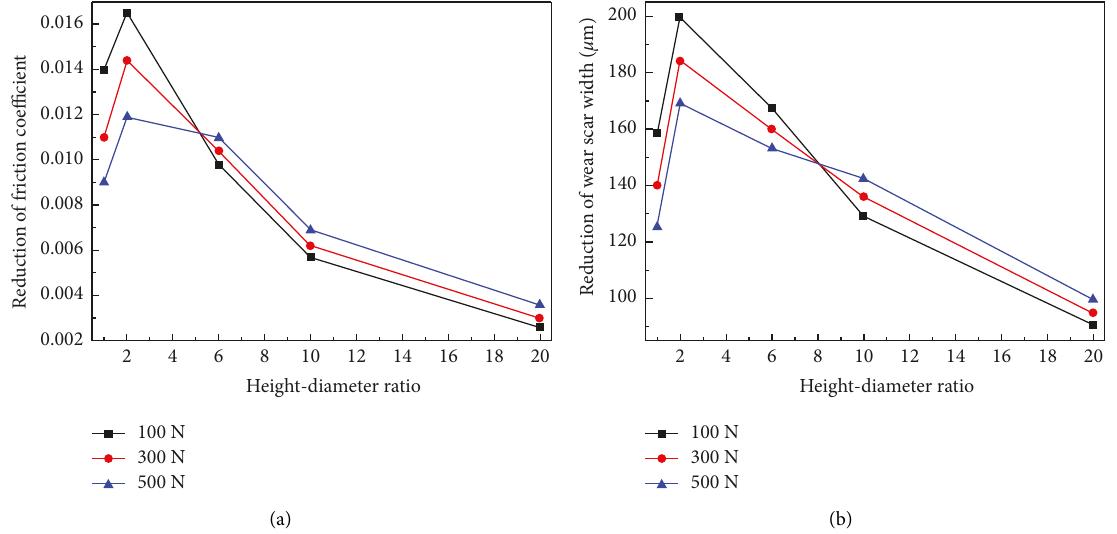
Figure 6: Reductions of (a) friction coefficients and (b) wear scar widths varied with height-diameter ratio (300 rpm).